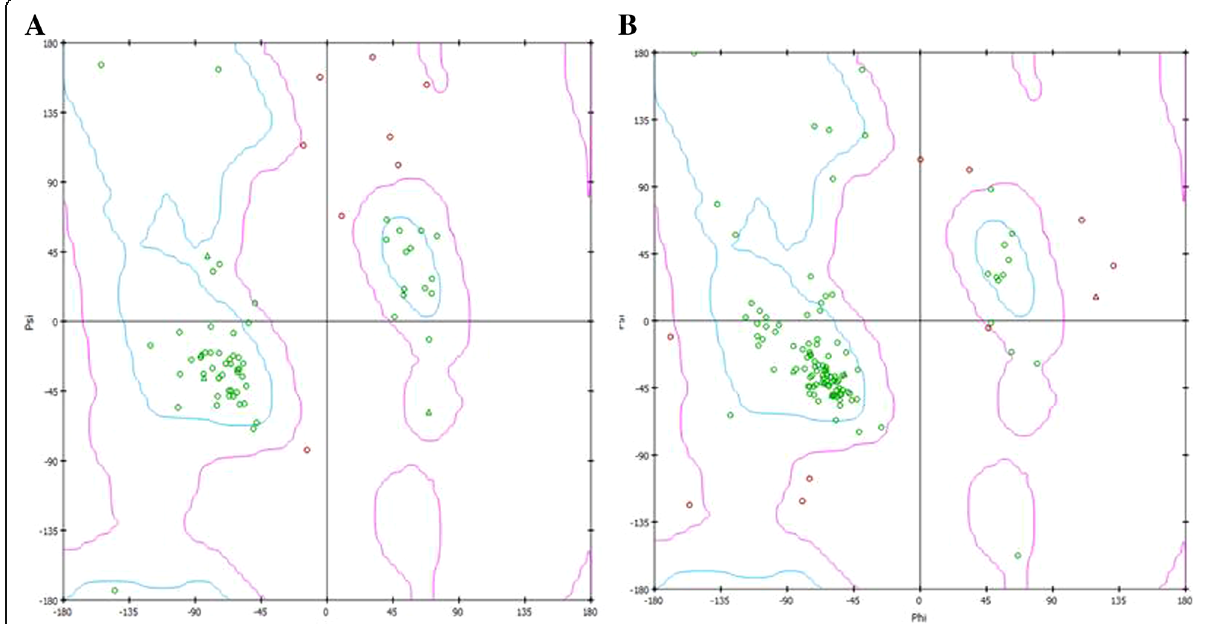
Fig. 7 Comparative Ramachandan plot of the two modeled domains by I-TASSER. a NEP protein of strain A/equine/Nador/1/1997(H3N8). b NEP protein of reference strain A/equine/Miami/1/1963 (H3N8): NEP structure of A/equine/Nador/1/1997 (H3N8). The results shown that NEP of Nador strain is characterized by a higher structural stability compared to that of Miami. This is explained by the ratio of the amino acids (black dot in two regions alpha and beta of protein). In Ramachandan plot was found that the upper left region could be divided into two: one on the left containing amino acids in beta leaves, and the other on the right with amino acids in random tangles